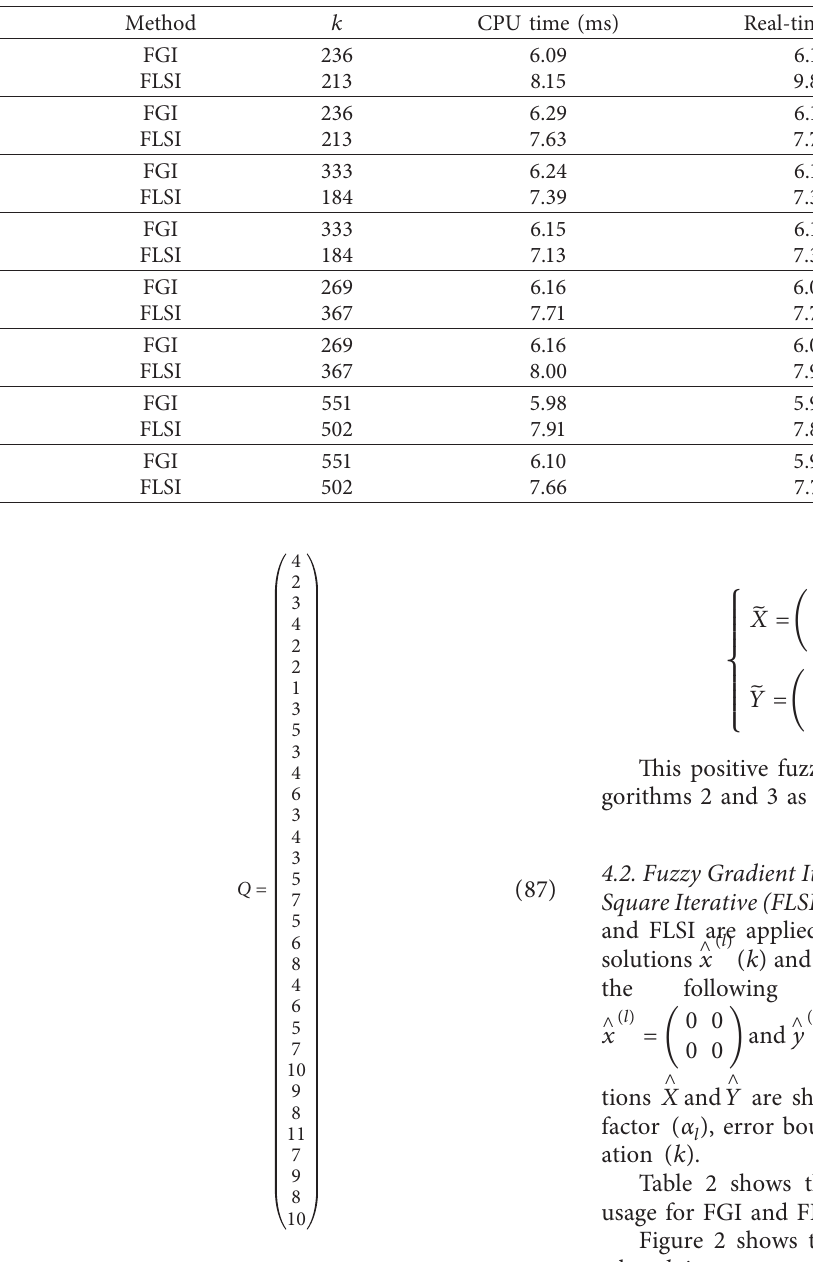
Table 2: Computational time and memory usage for FGI and FLSI for Example